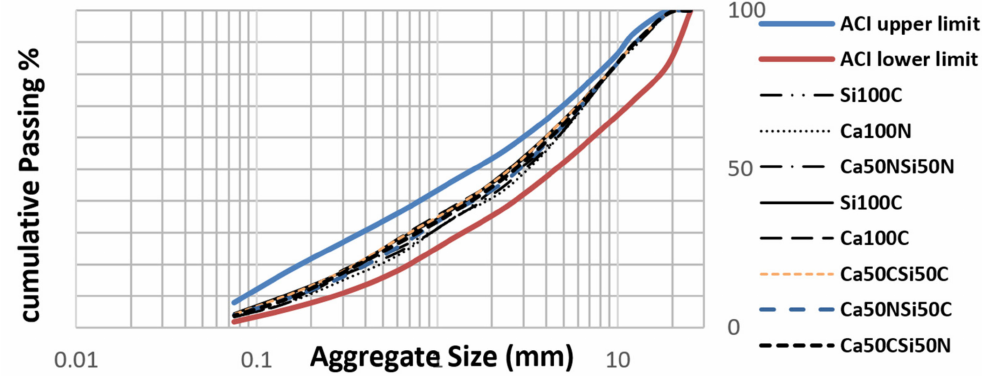
Figure 1. Different RCC mixture